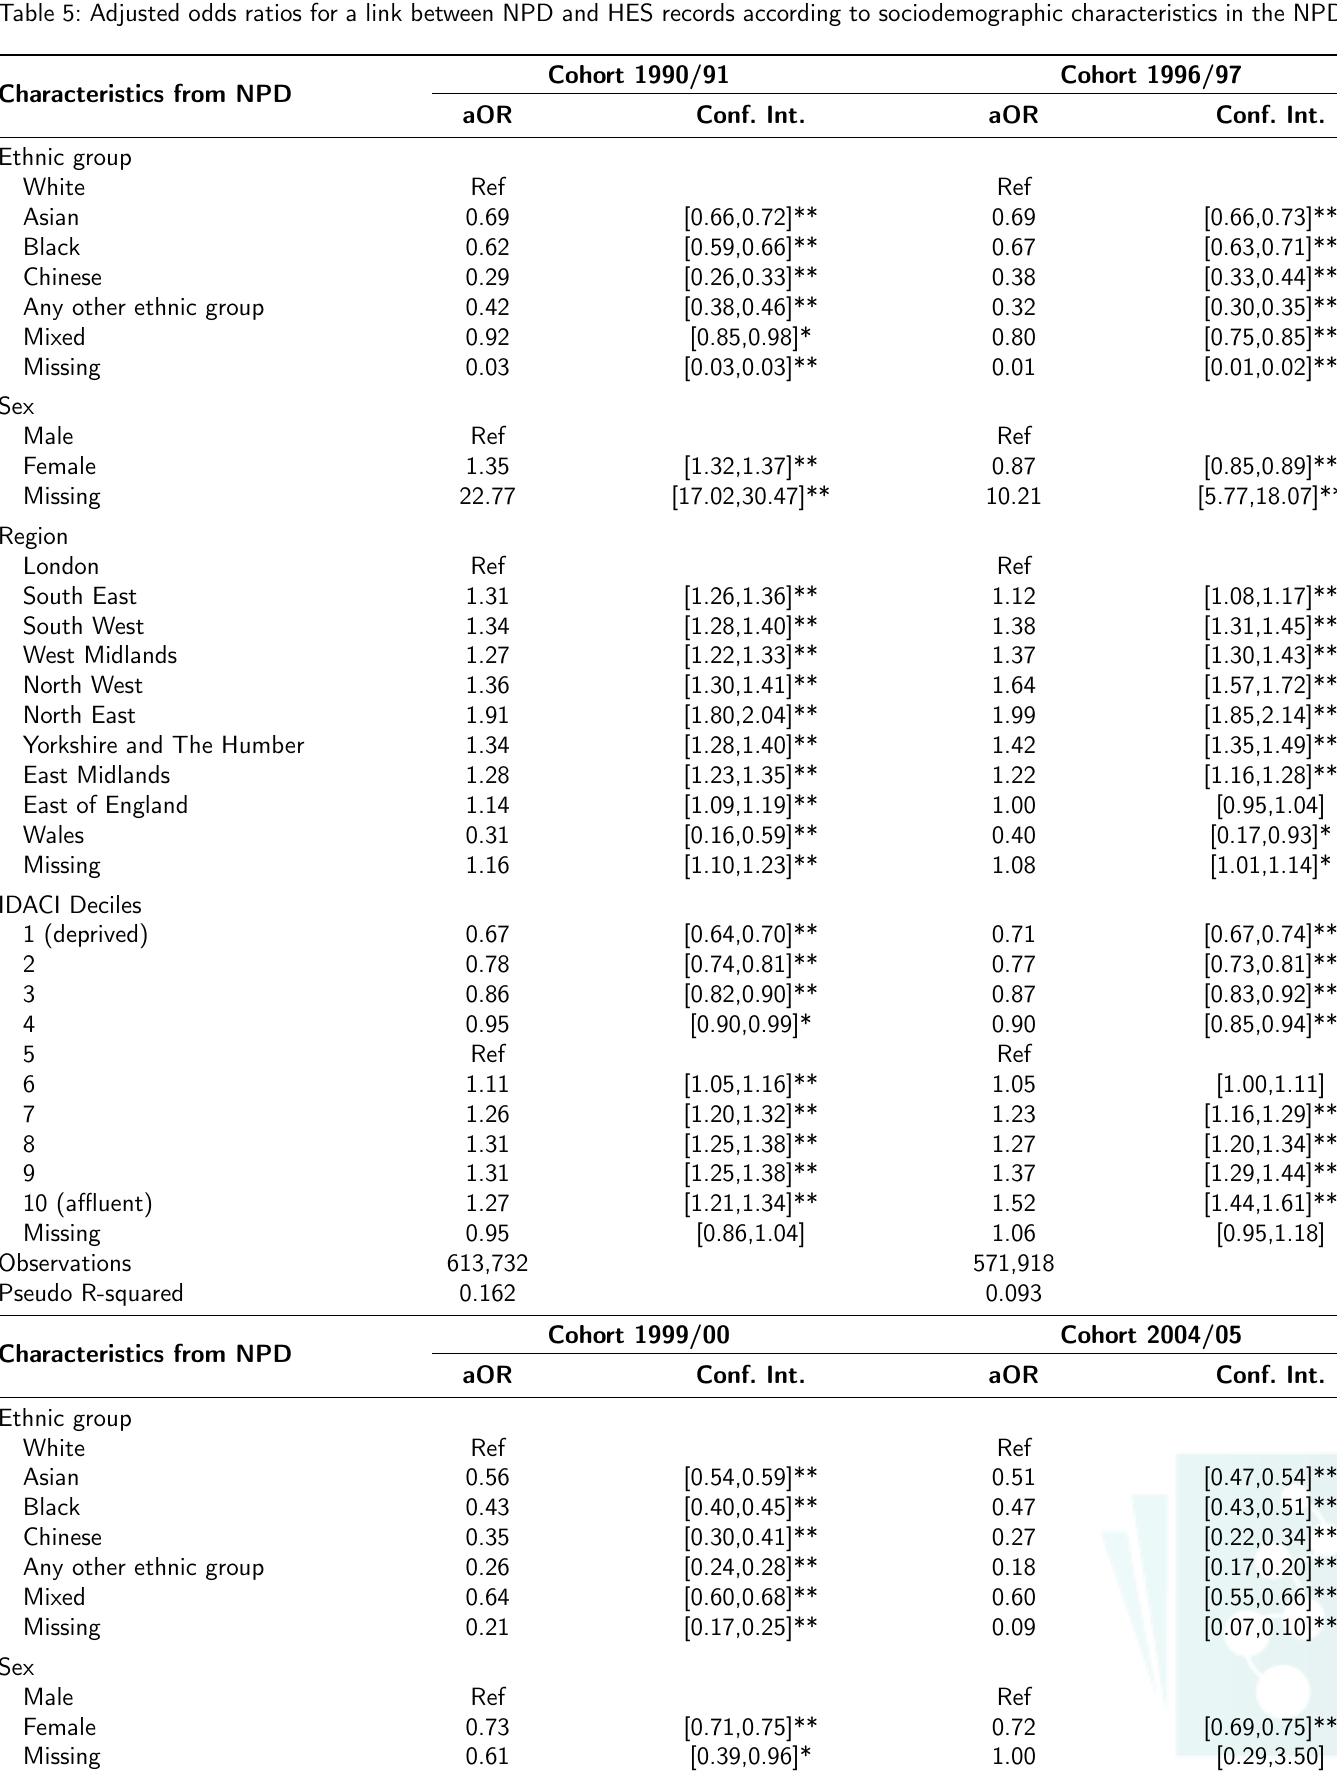
Table 5: Adjusted odds ratios for a link between NPD and HES records according to sociodemographic characteristics in the NPD Cohort 1990/91 Cohort 1996/97 Characteristics from NPD aOR Conf. Int. aOR Conf.